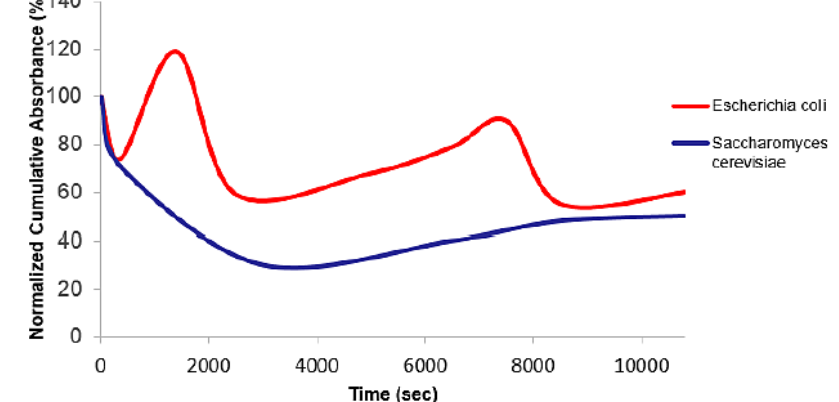
Figure 11. The percentage of cumulative absorbance of E. coli and S. cerevisiae cells that passed through the detection channel as a function of time at the pulsing time of 12 s applied with a flow rate of 9.6 µ L min − 1